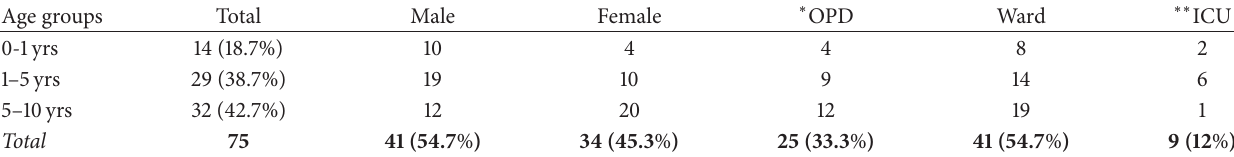
Table 1: Age and area wise distribution of E. coli among children ( < 10yrs).